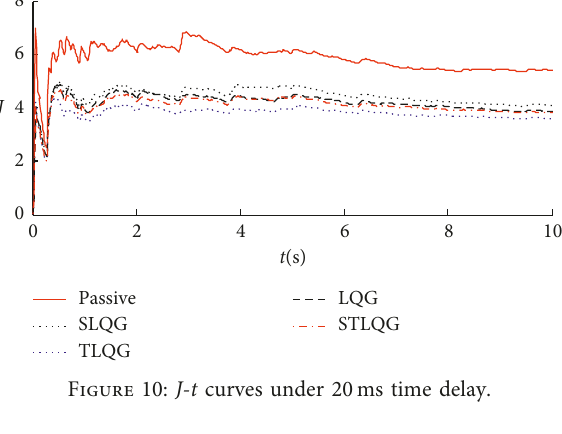
Figure 13: PSD ( a 2 )-frequency curves under 15 ms time delay.